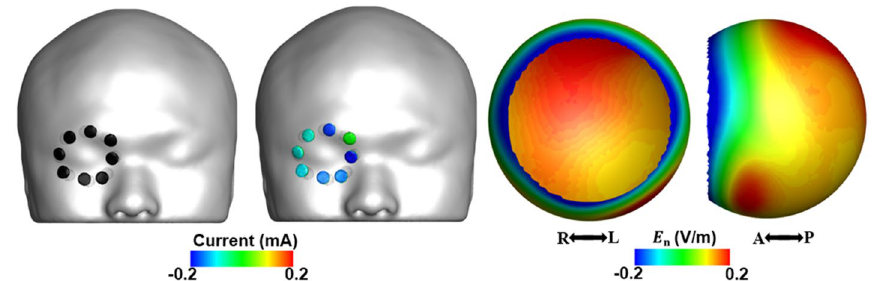
Figure 7. Injection current pattern and electric field distribution in the retinal surface when the active electrodes were slightly displaced from their original locations in the clockwise